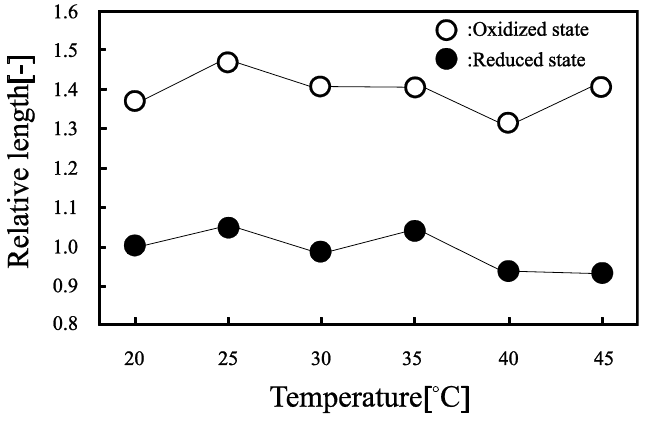
Figure 8. Equilibrium swelling ratio of poly(VP- co -Ru(bpy) solutions as a function of temperature. (●) [Ce [Ce(SO ) ] = 0.001 M and [HNO 4 2 characteristic diameter at the initial state at 20 °C. Reprinted from Ref. [33] with permission; © The American Chemical